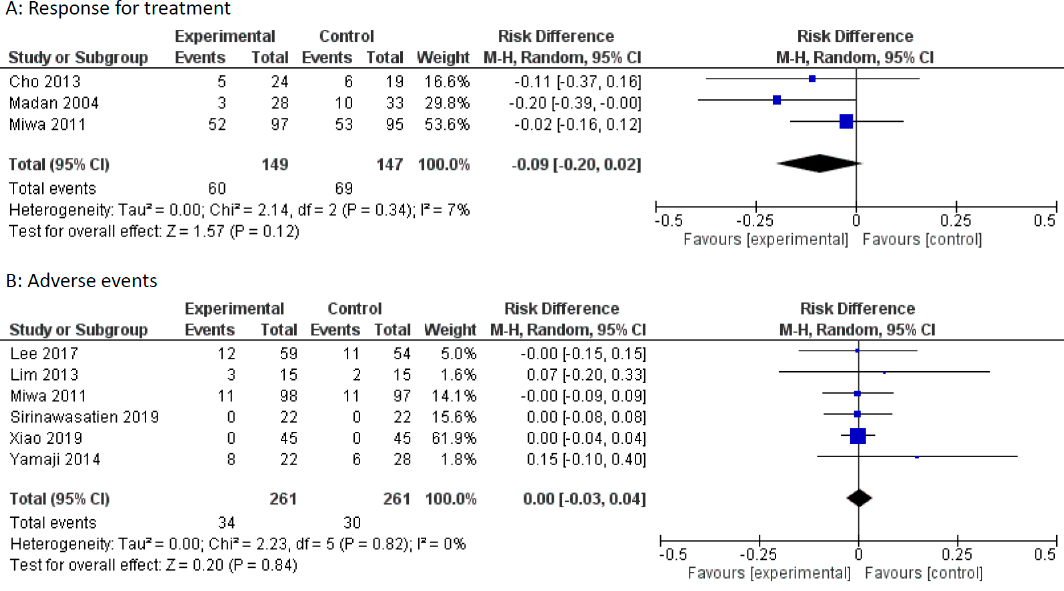
Figure 4. Forest plot of the risk difference (RD) with 95% CI for mosapride combined with PPI versus PPI alone for gastroesophageal reflux disease. ( A ): Response for treatment. Events represent treatment failure. ( B ): Adverse events.